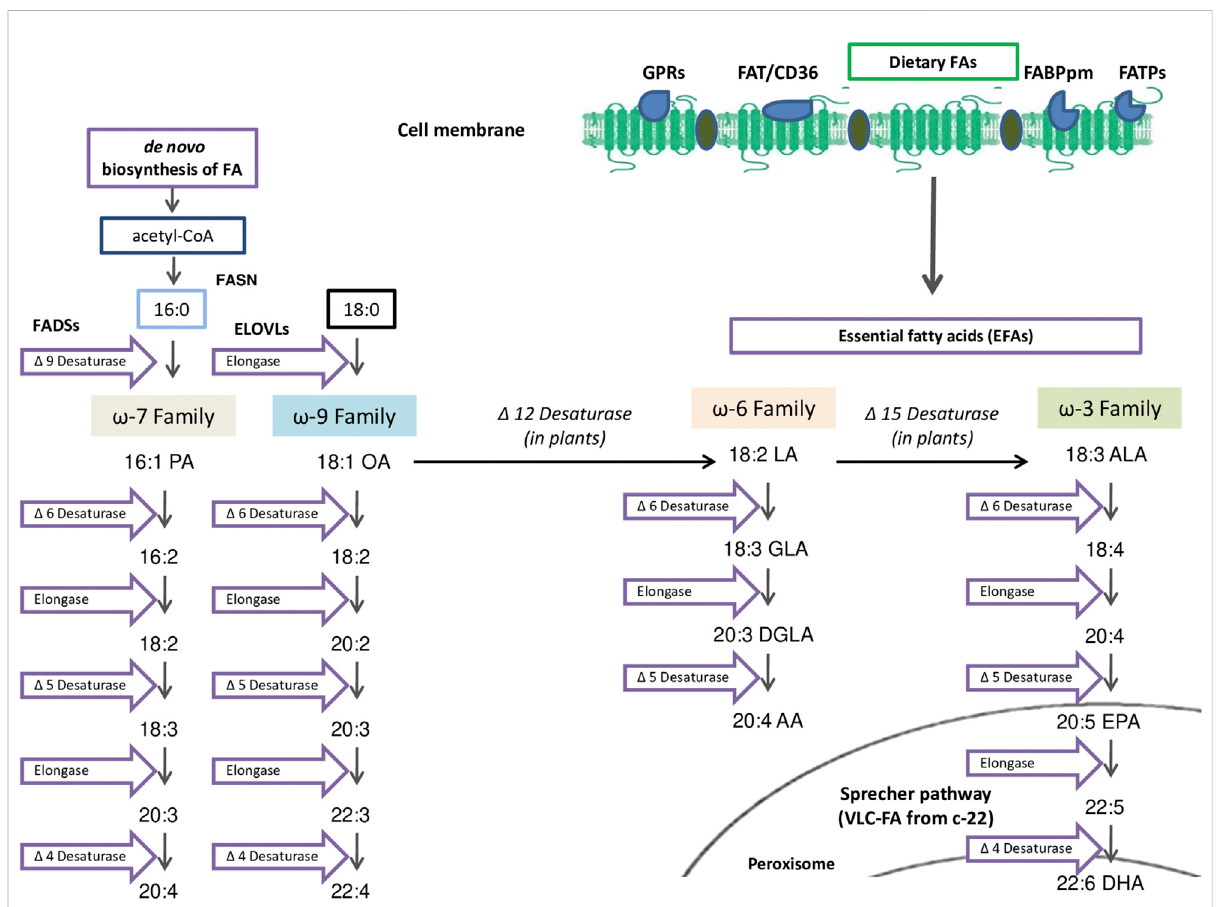
Polyunsaturated FA (PUFAs) and Essential FA (EFAs) metabolism: PUFAs can be provided by exogenous uptake from the surrounding microenvironment facilitated by specialized transporters such as the fatty acid transport protein (FATPs), the fatty acid – binding protein-plasma membrane (FABPpm), G-protein coupled receptors (GPR) and fatty acid translocase lipid microdomains (FAT/CD36). In mammals, essential FAs (EFAs)suchasLinoleicAcid(LA18:2 ω -6)or α -LinolenicAcid(ALA18:3 ω -3)arebothuptakenbecausetheycannotbesynthetizeendogenously. LA and ALA metabolized competitively by ELOVLS and FADSs that can introduce double bonds at the Δ 5 or Δ 6 position to synthetize long-chain FAs (LC-FA) or subsequently, very-long-chain FAs (VLC-FA) in peroxisome by Sprecher